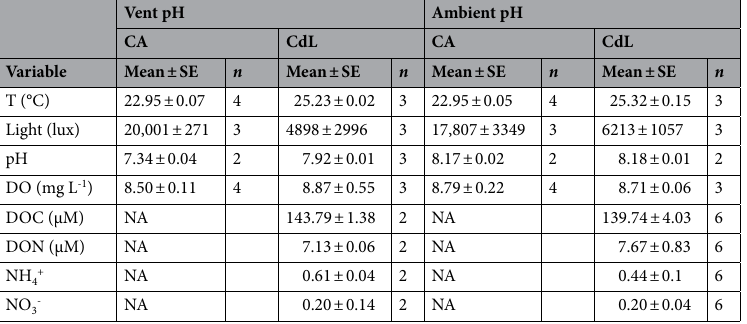
Table 1. Environmental parameters (mean ± SE, n ) measured at vent and ambient pH sites at Castello Aragonese (CA) and Chiane del Lume (CdL). Temperature, light, pH, and DO were continuously measured with data loggers (between 12 am and 2 pm of the respective incubation day). DOC, DON, NH 4+ , and NO 3- were analyzed from samples collected on the respective sampling